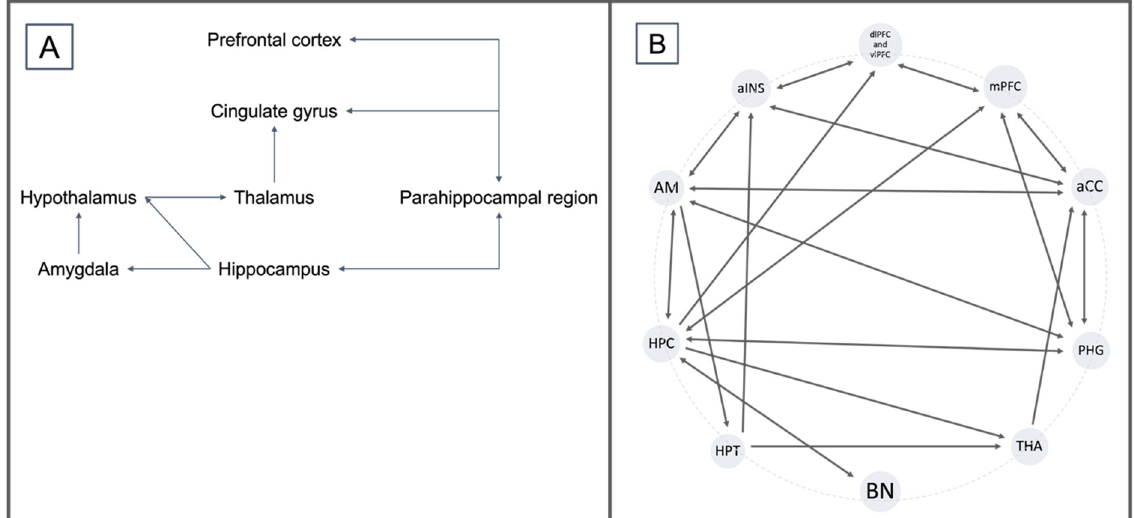
Figure 2. ( A ) Emotional control circuitry according to the Papez model of 1937. ( B ) Description of an off-centric model based on the Papez model and the description of neuroanatomical interactions in PTSD by Zhao et al., 2013; Aminoff et al., 2013; Zhang et al., 2016; and Benarroch et al., 2019.